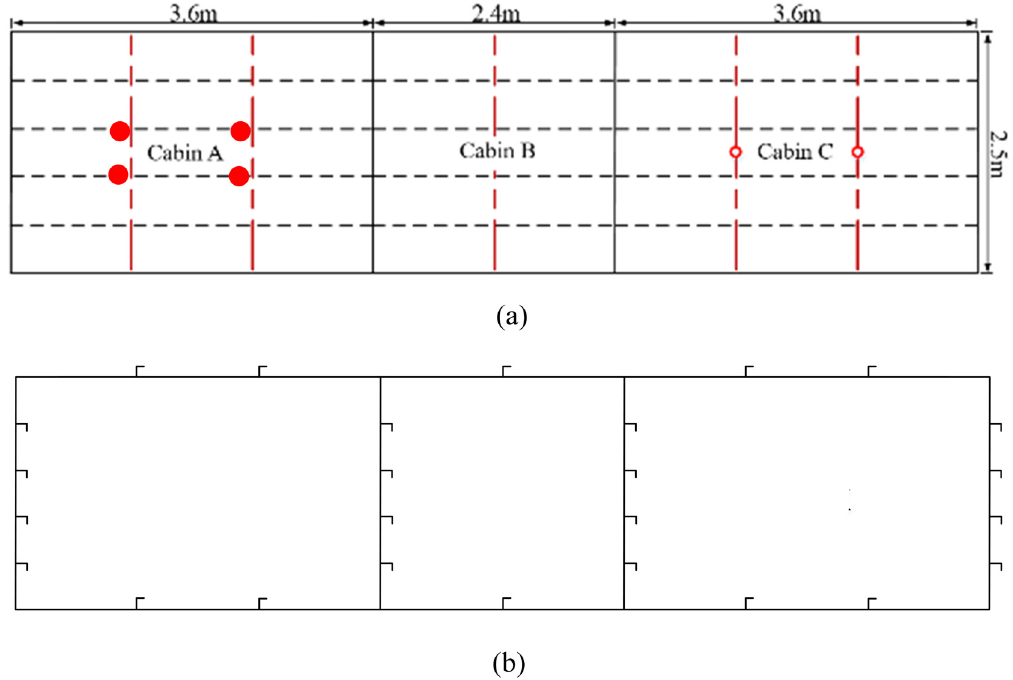
Figure 1: Diagram of cabin structure: ( a ) deck structure and ( b ) bulkhead